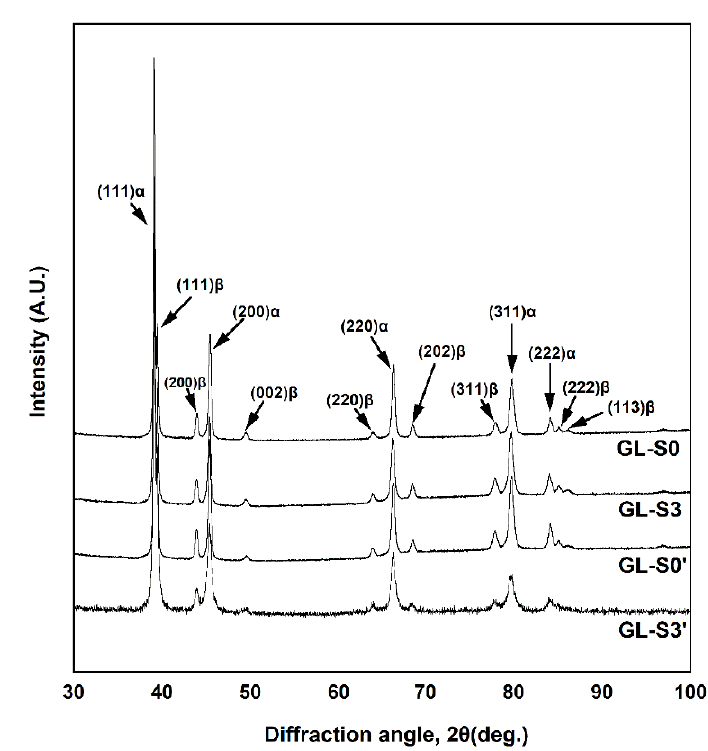
Figure 7. XRD patterns of the specimens after glaze.